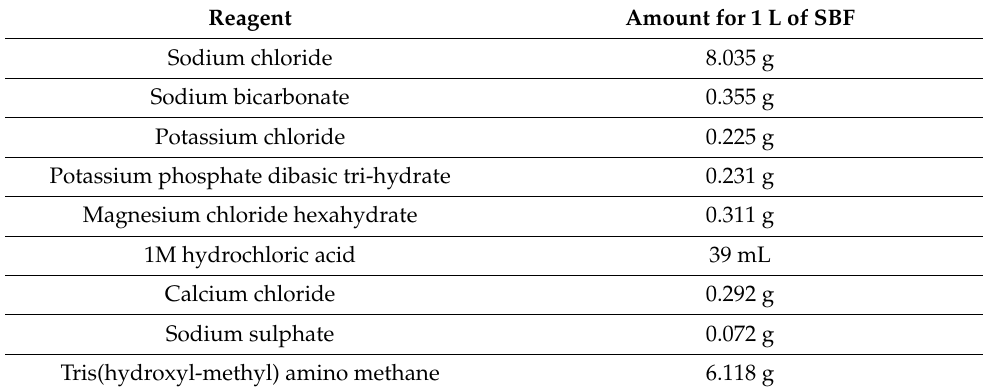
Table 2. Reagents for preparing the updated simulated body fluid [20]. (reprinted from ref. [20] with permission from